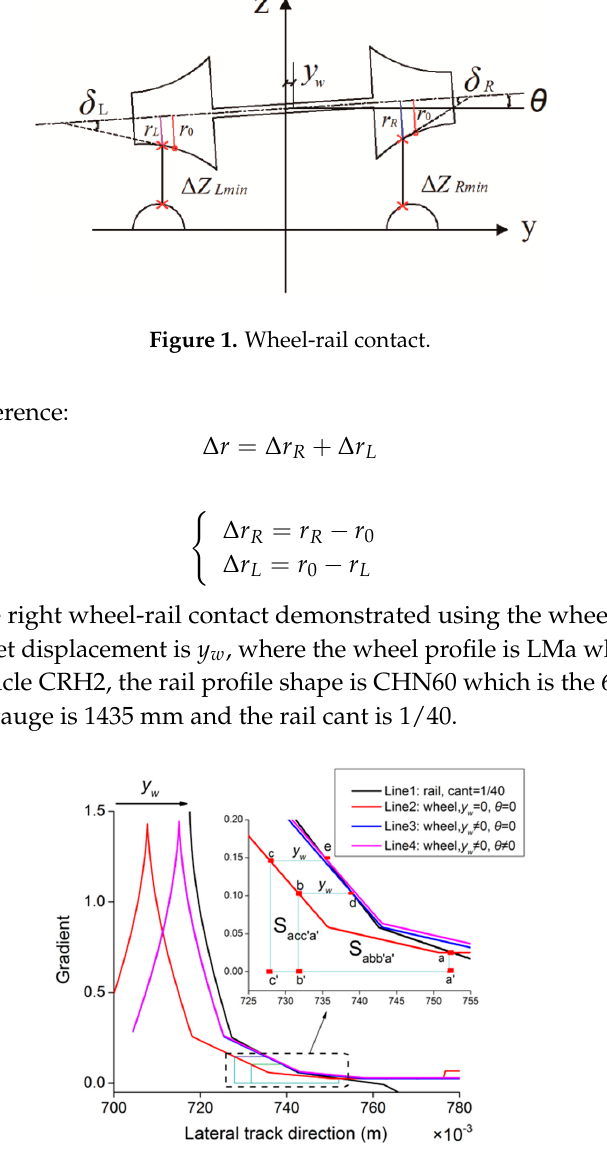
Figure 2. Right wheel-rail contact demonstrated using the wheel-rail profile gradient.